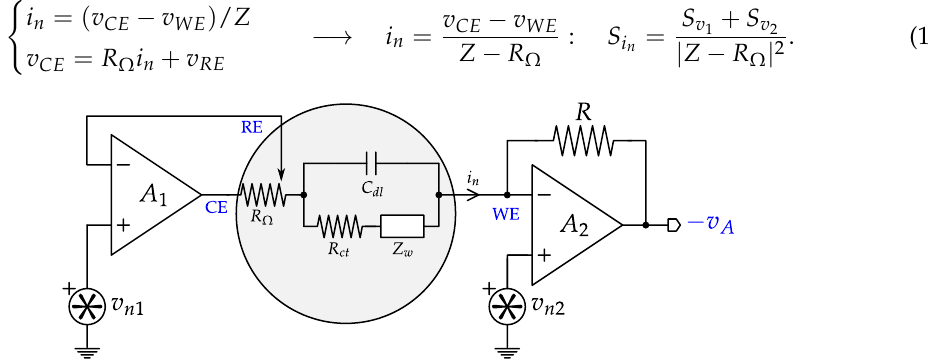
Figure 11. Noise sources in a transimpedance-amplifier based amperometric readout. Configuration ( a ) of Figure 10 is considered